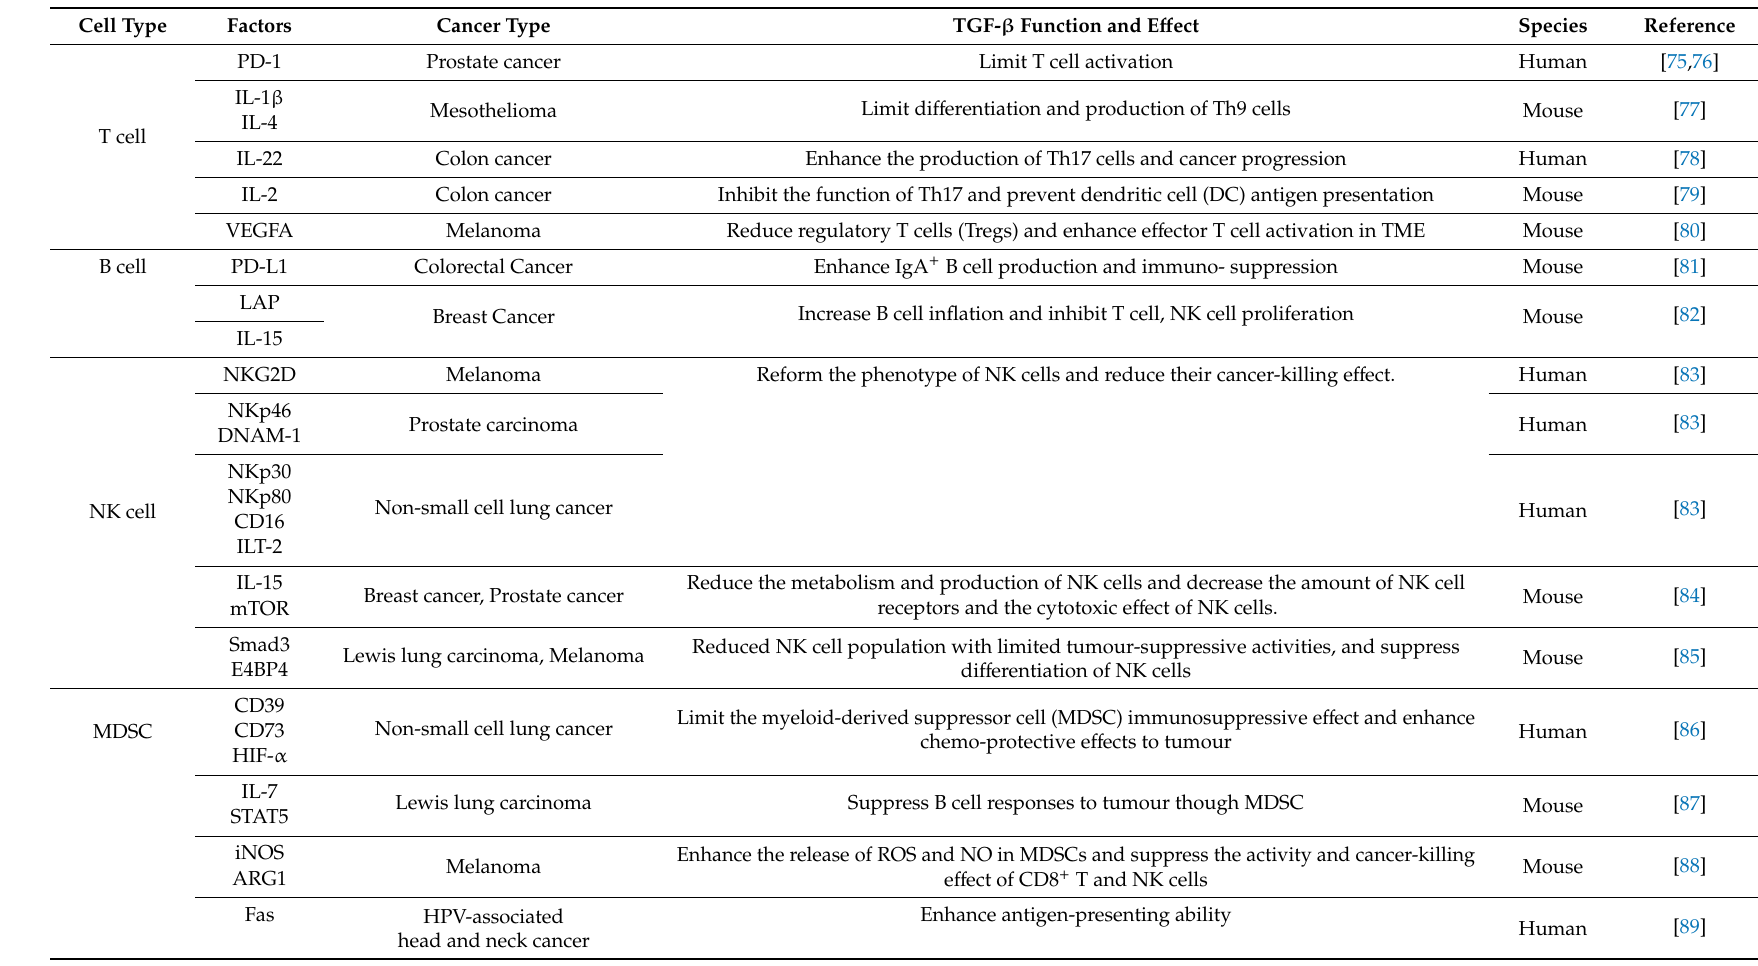
Table 1. Mechanistic e ff ectors of the TGF- β pathway in the